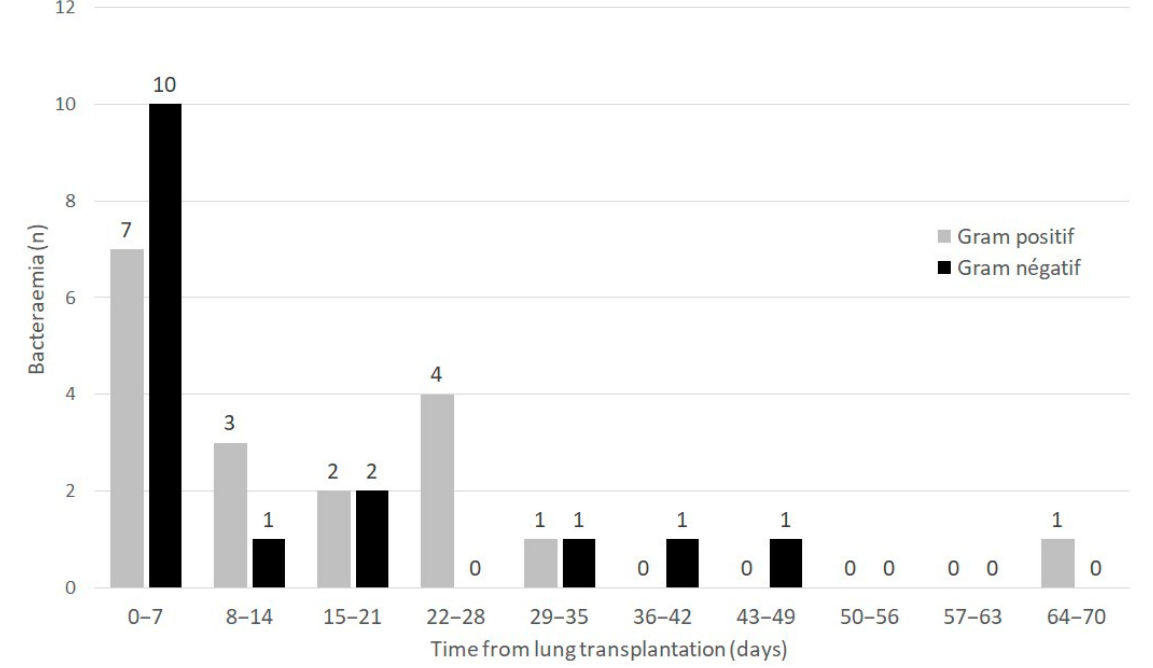
Figure 1. Distribution of first episodes of bacteraemia according to Gram stain and time from lung